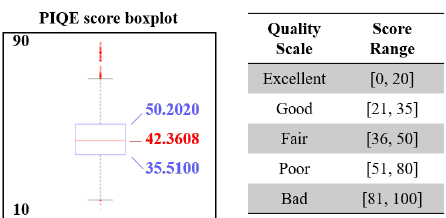
Figure 12. Perception based Image Quality Evaluator (PIQE) score boxplot (lower is better) computed on the Azores validation dataset. The quality of the cropped images that are used to validate the CNN proposed in this work range from 11.6928 (excellent) to 89.5572 (bad). The median value is shown in red 42.3608